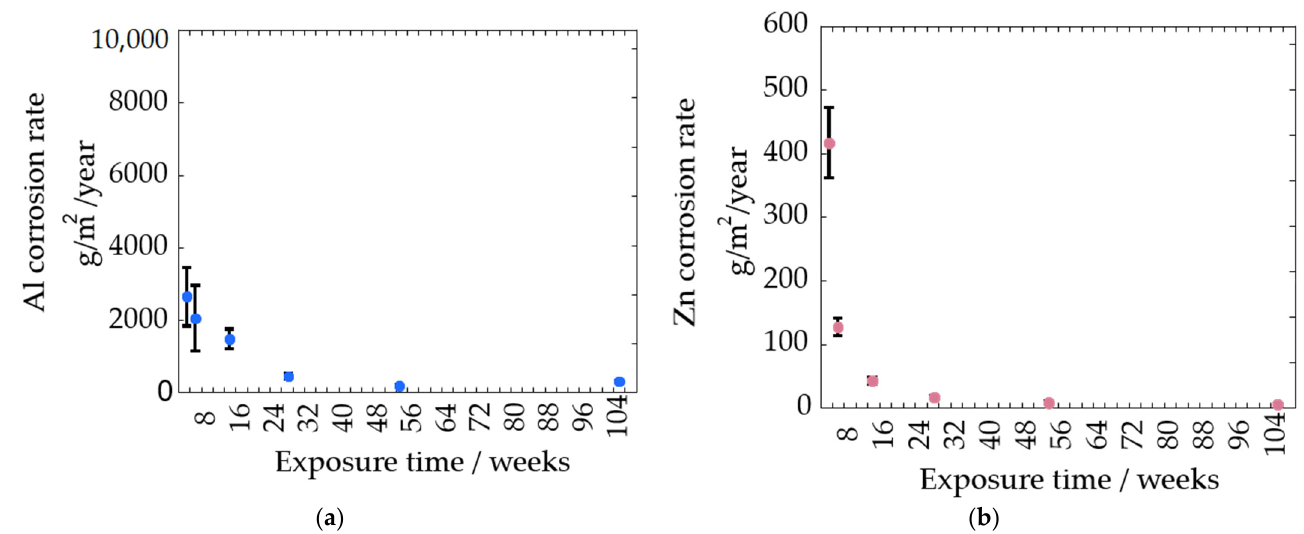
Figure 6. Corrosion rates of Al ( a ) and Zn ( b ) embedded in concrete immersed in artificial ground water (AGW) at anaerobic conditions for 2, 4, 12, 24, 52 and 104 weeks.